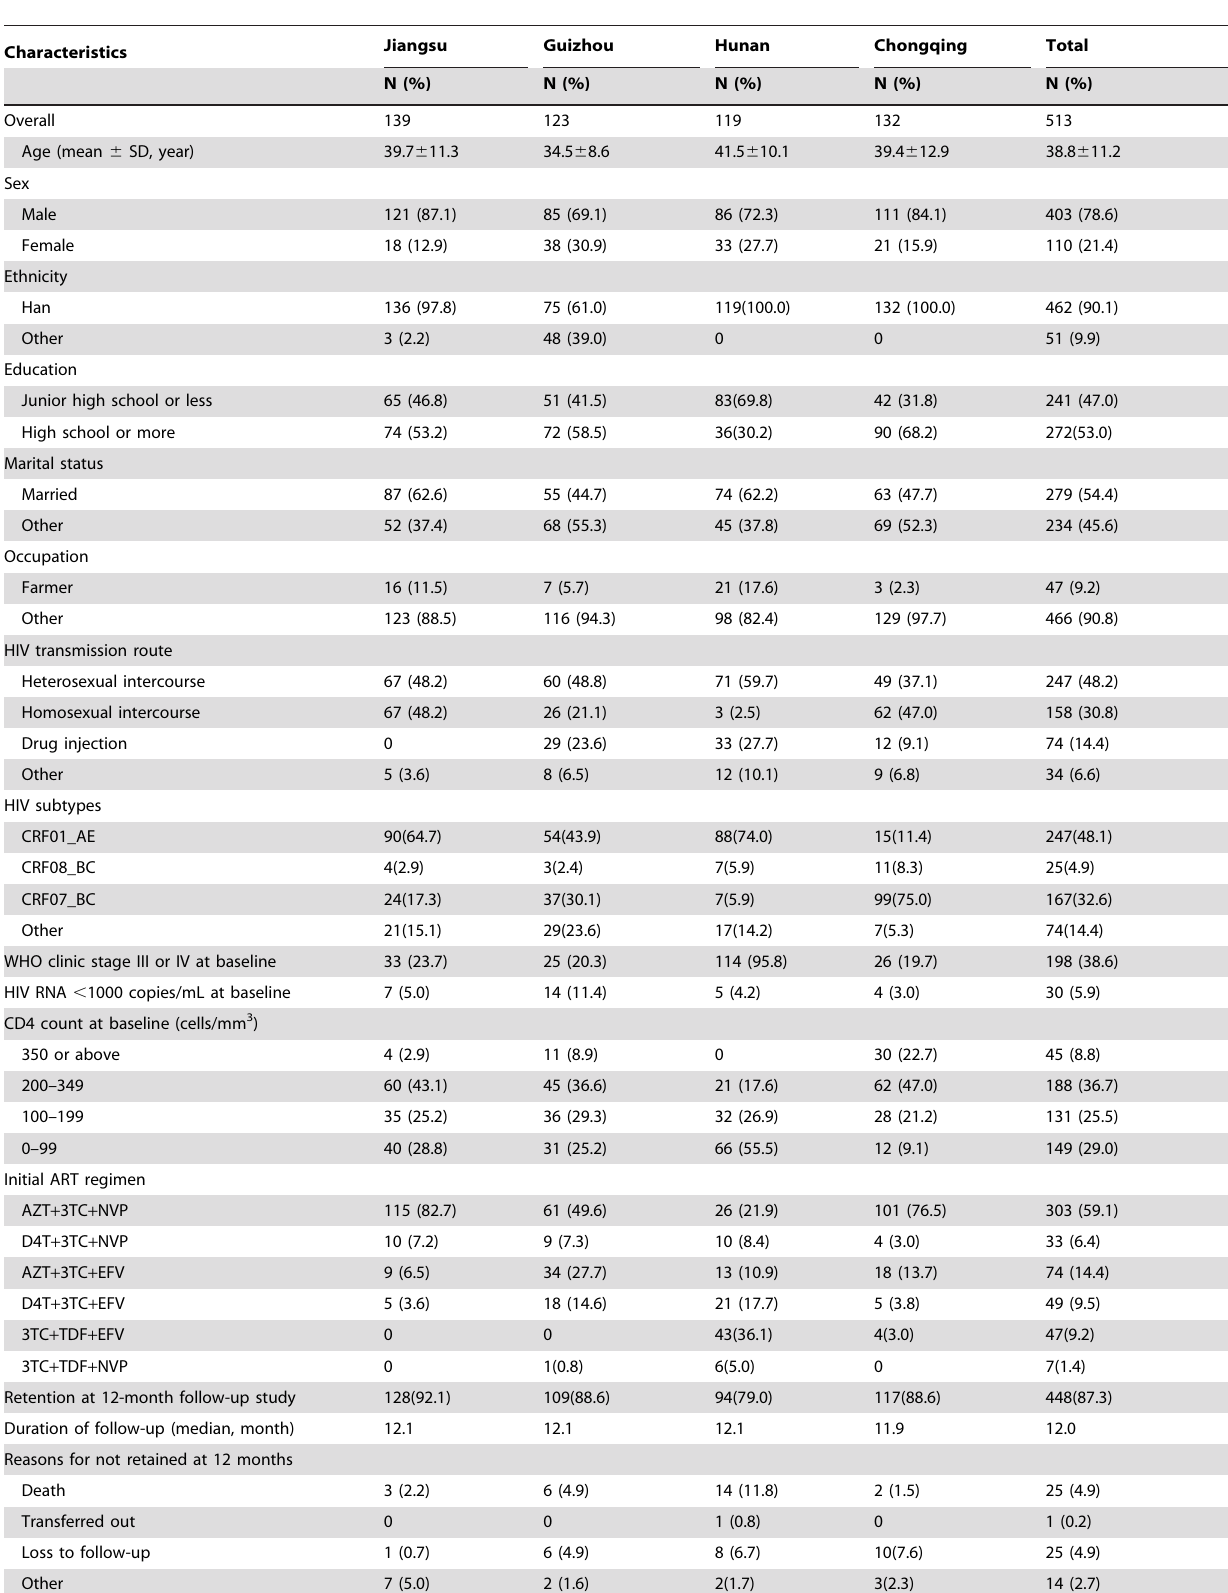
Table 1. Characteristics of HIV patients receiving first-line ART in four sentinel antiretroviral treatment sites.